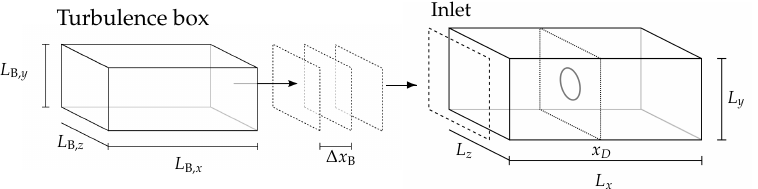
Figure 2. Introduction of synthetic turbulence field into the